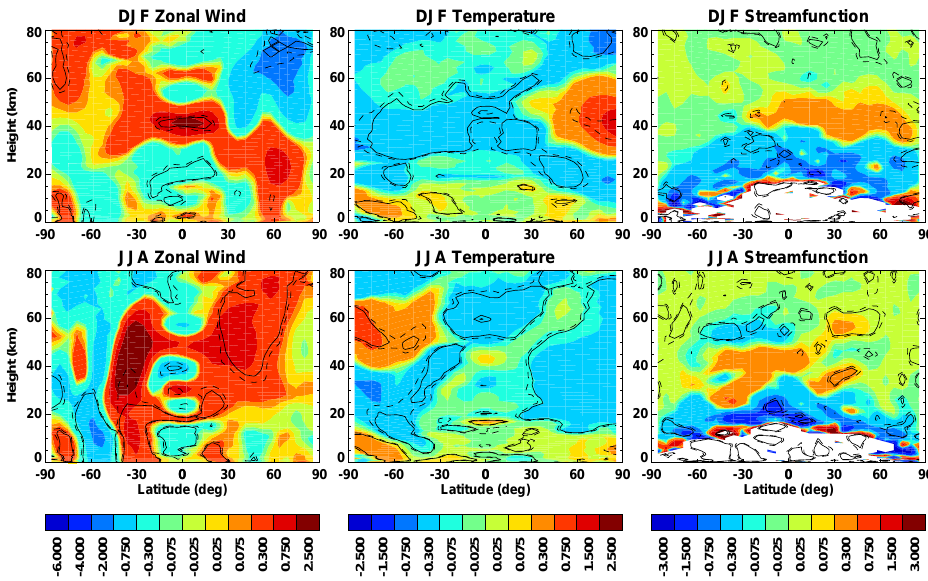
Fig. 10. December–February run mean, ensemble mean (top) and June–August run mean, ensemble mean (bottom) difference of the combined EPP ensemble run from the reference ensemble run for zonal wind (left, m/s), temperature (center, K), and mass streamfunction (right, kg/m/s, values outside the (-4,4) interval not plotted).